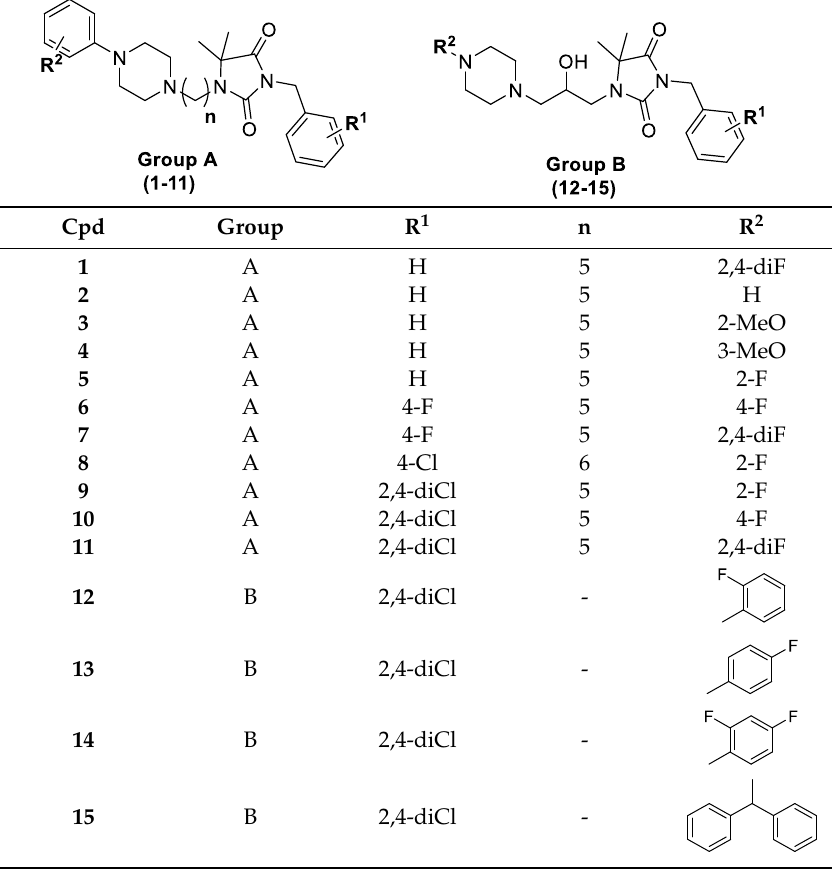
Table 1. Structures of phenylpiperazine 5,5- dimethylhydantoin derivatives ( 1 – 15 ) investigated in the study.